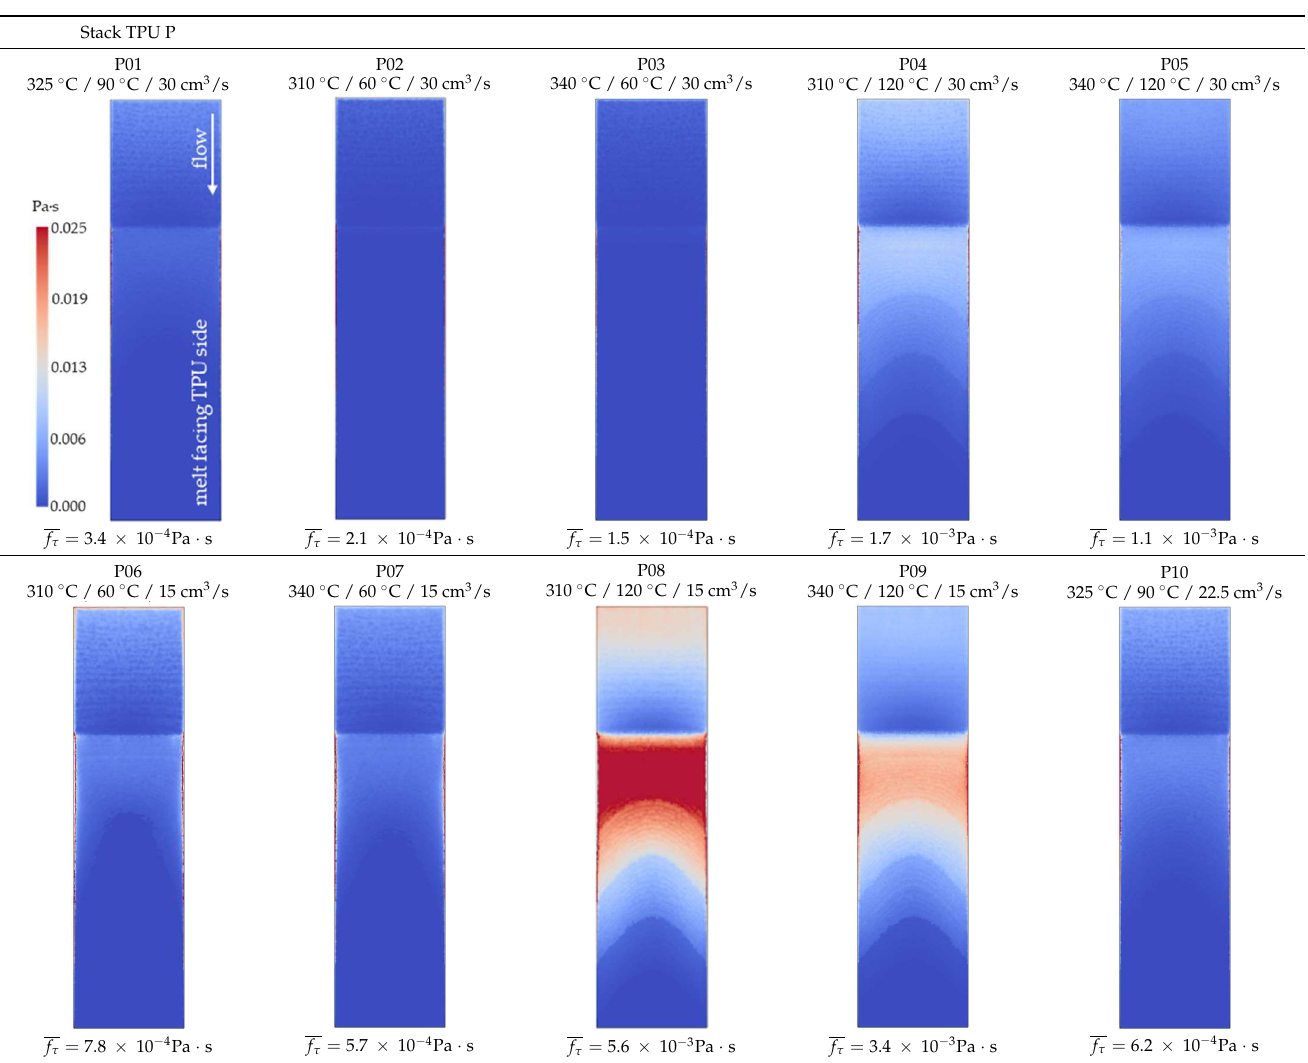
Table 6. Shaded contour plots of the calculated shear distortion factor for film strips using TPU P for molding settings as outlined in Table 1.